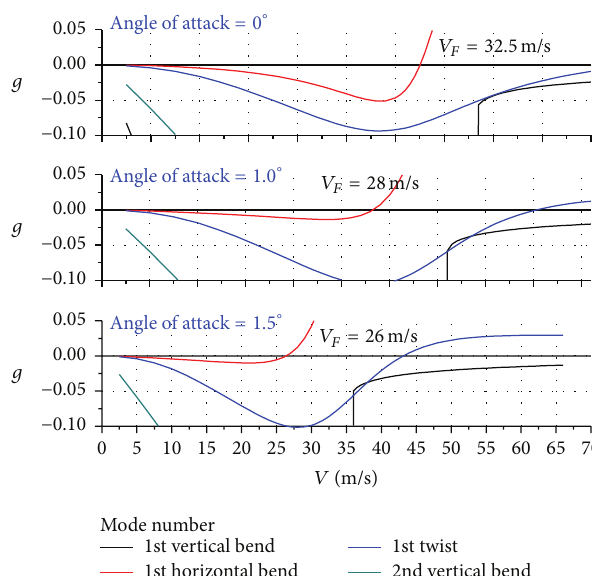
Figure 22: Nonlinear analysed flutter speed under different angles of attack.